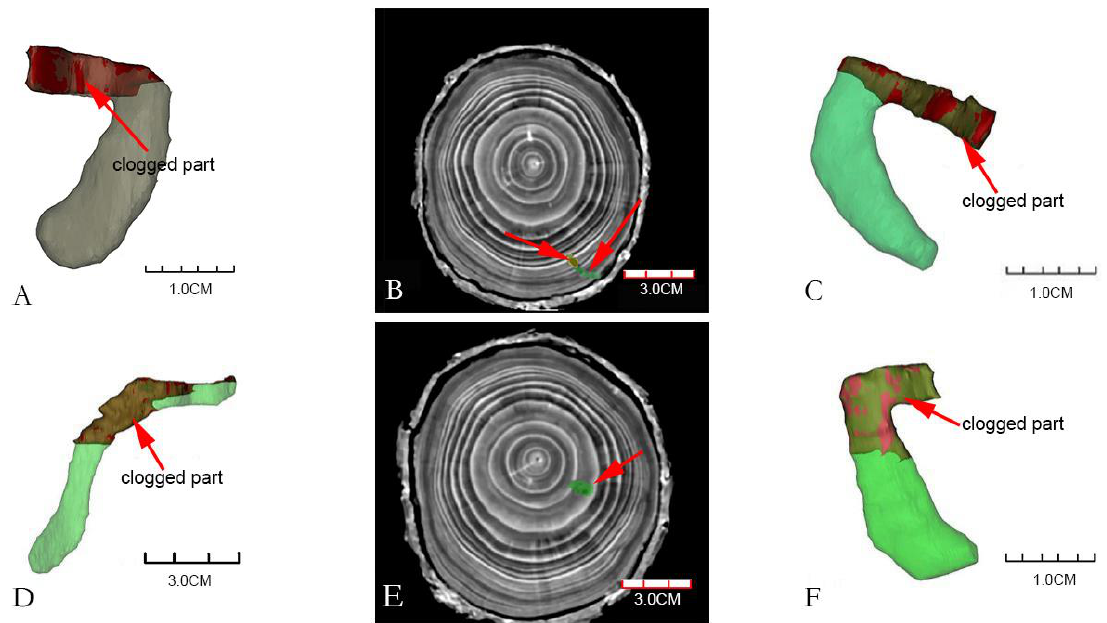
Figure 4. Blocked parts of Monochamus alternatus galleries. (( A ),( C ),( F ): the blocked parts of C-shaped are at the beginning of the galleries; ( D ): the blocked part of S-shaped is located in the middle of the gallery. ( B ),( E ): the images of the transverse section of the CT images of the galleries, note the degree of blockage of the galleries by frass – feces mixture (red arrow), the blocked part of the gallery (indicated by green), the unblocked part of the gallery (indicated by yellow)).